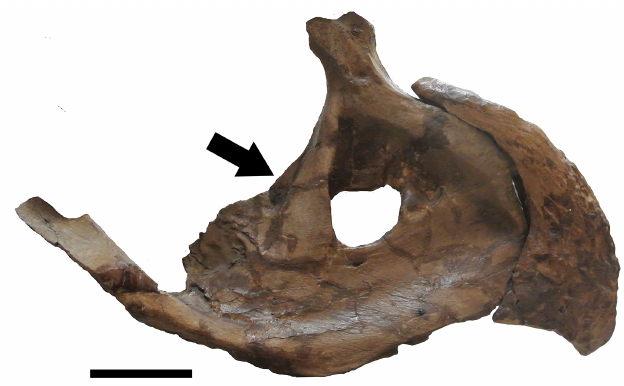
Figure 6. Right premaxilla of YPM 1821 (holotype specimen of Triceratops ‘ flabellatus ’). Arrow indicates septal flange at the base of the narial strut. Scale, 10 cm. Courtesy of the Division of Vertebrate Paleontology; YPM 1821, Peabody